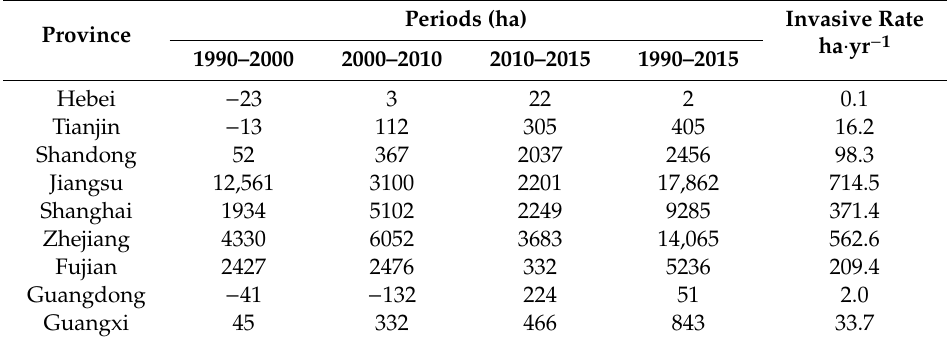
Table 2. Changes in area of S. alterniflora over the different coastal provinces.